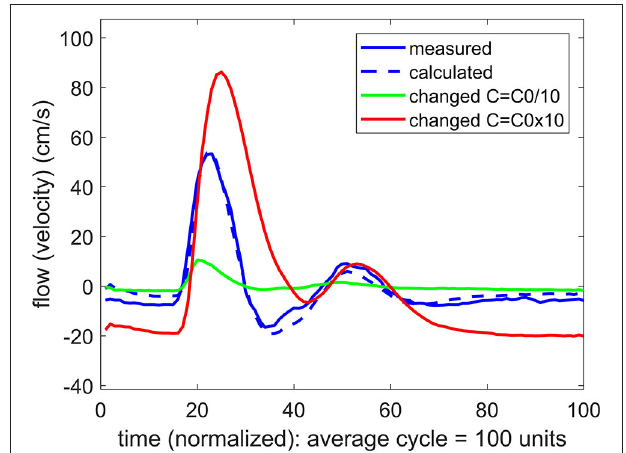
FIGURE 5 | A test of the role of compliance “ C ” in the relationship between pulsatile pressure and flow (velocity) in pulsatile blood flow within the vascular bed of the forearm. The actual compliance “ C 0 ” of the vascular bed is determined by agreement between the measured and predicted flow waveform. When this value of C is changed to either higher or lower values, the predicted flow (velocity) waveform becomes vastly different from the measured flow waveform, indicating that compliance is playing a significant role in the relationship between pulsatile pressure and flow.